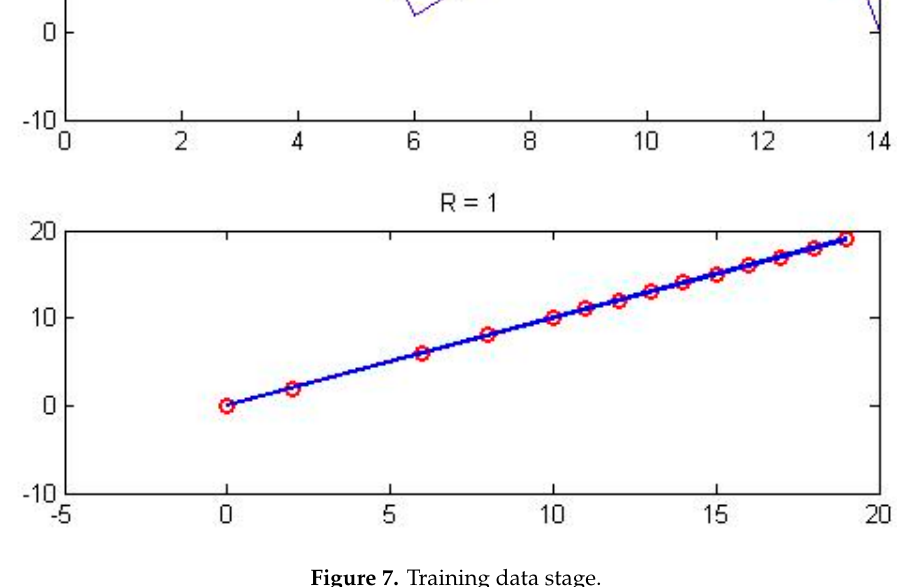
Figure 7. Training data stage.